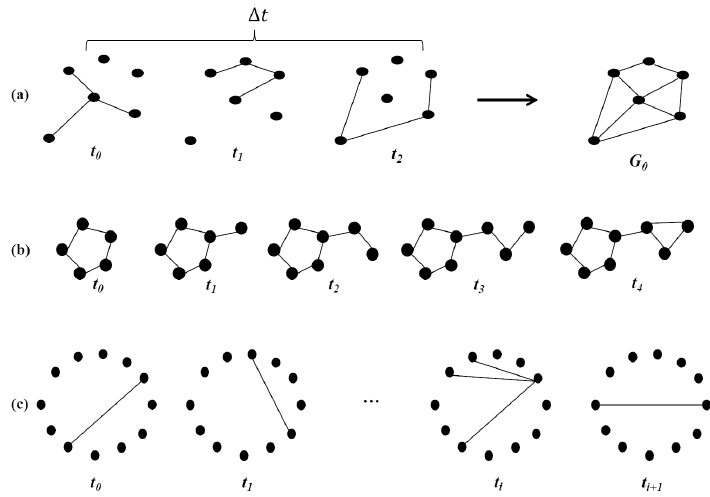
Figure 1. Several different forms of data. ( a ) is the data used in structure-based methods, temporal data in a time window of size ∆ t is mixed to snapshot G 0 . Incremental analysis in ( b ) knows the structure of network at the beginning and addition of nodes and edges (or delete) to change local structure so that the new communities grow. ( c ) is a real data set called Students where it is hard finding community structure at any t i and the information flow is spare when edges